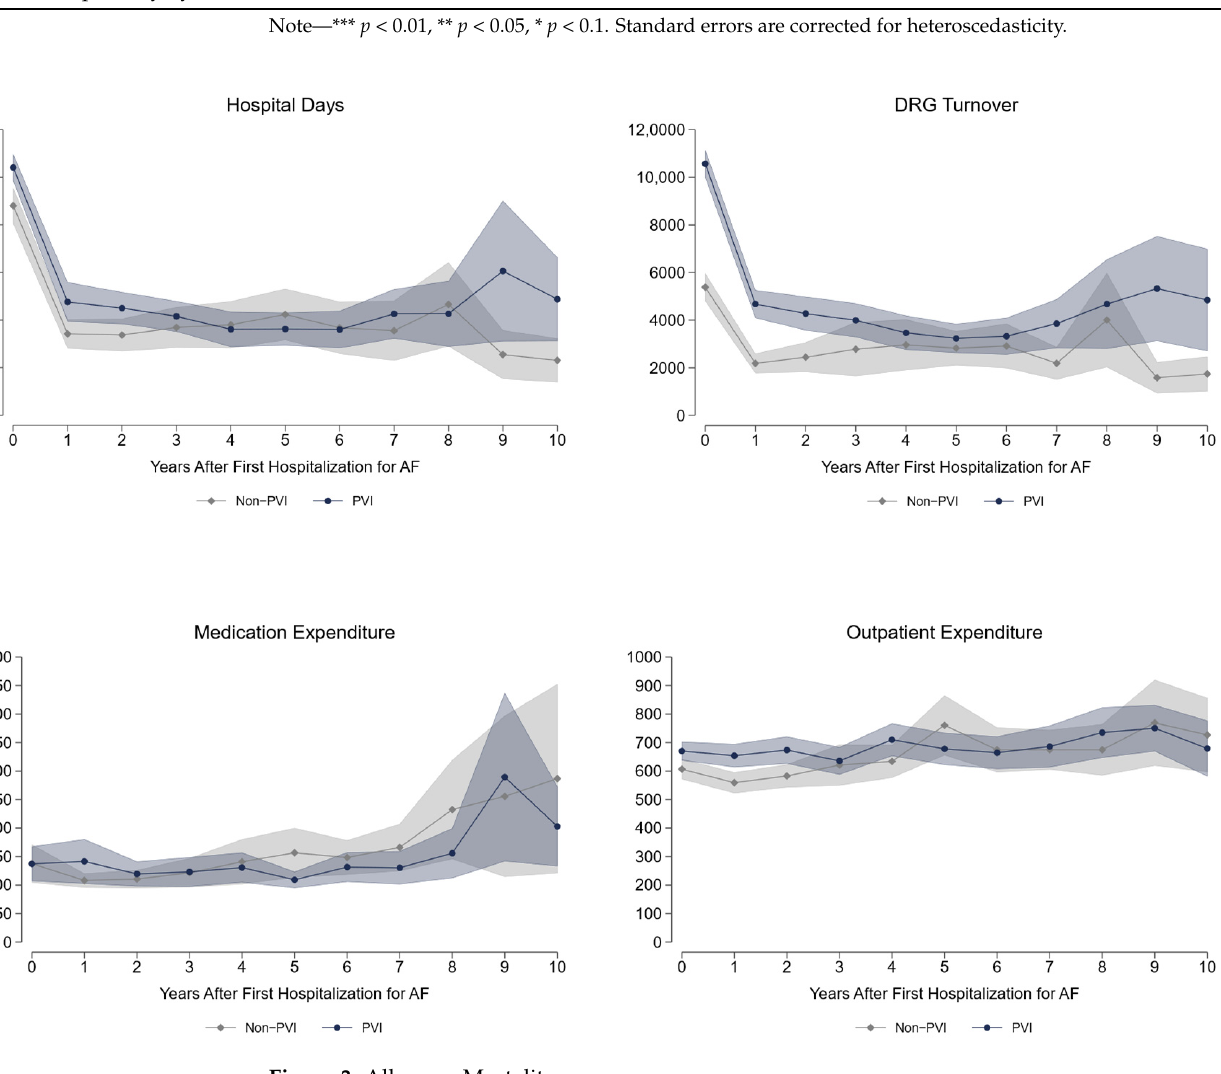
Figure 2. Long-term healthcare Expenditure and Hospital days.